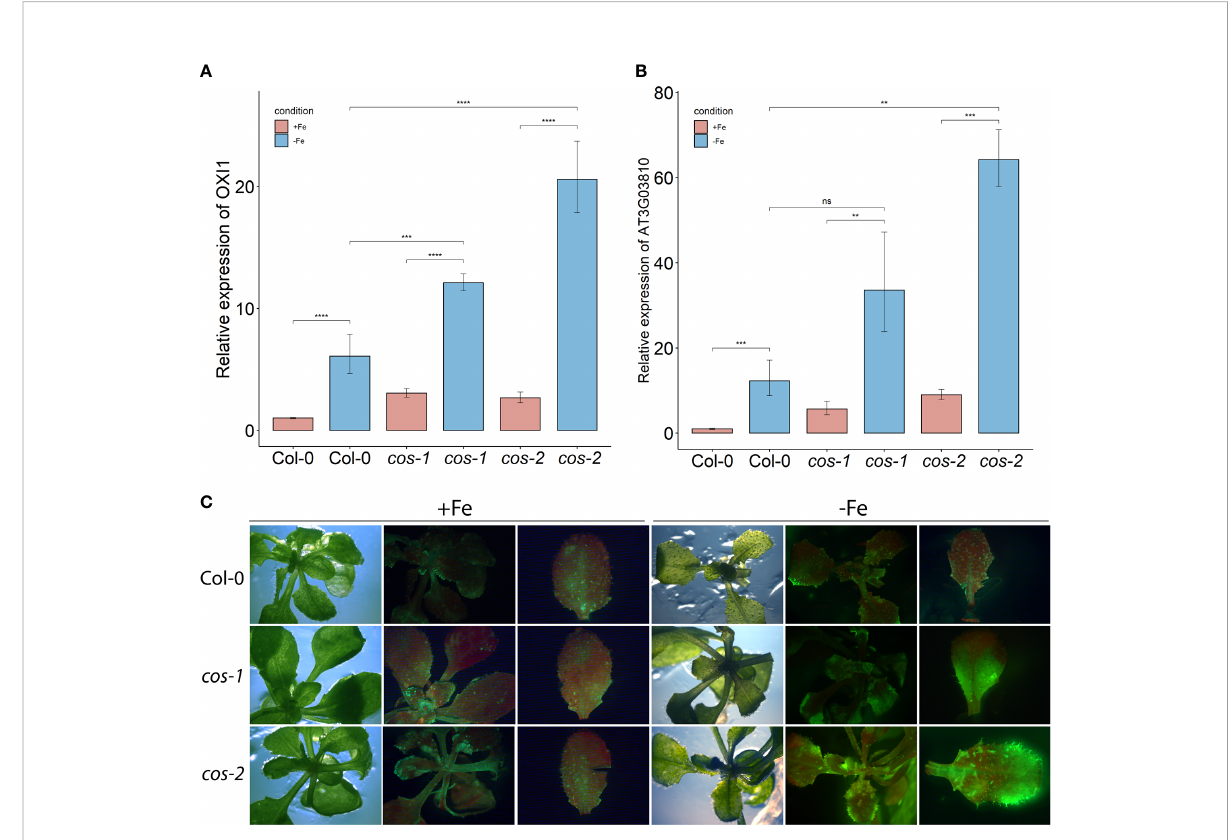
FIGURE 5 ROS in leaves of cos T-DNA mutants. RT-PCR of oxidative stress marker OXI 1 (A) and singlet oxygen marker AT3G0381 0 (B) in WT and cos mutant shoots. Seedlings were grown on 1/2X MS agar with 50 m M Fe-EDTA for 14 d followed by a growth period of 3 d either on Fe-suf fi cient or Fe-de fi cient MS agar medium. Bars represent means ± SD of relative transcript levels normalized to ACT2 (n=3). (C) Singlet oxygen detection in cos mutants by SOSG. Seedlings were grown on 1/2X MS agar with 50 m M Fe-EDTA for 14 d followed by a growth period of 3 d either on Fe- suf fi cient or Fe-de fi cient MS agar medium. Seedlings were stained with SOSG and incubated under high light (500 µmol photons m − 2 s − 1 ) for 30 minutes. SOSG fl uorescence is represented by green while chlorophyll auto fl uorescence is represented by red. * represents p-value ≤ 0.01, ** represents p-value ≤ 0.001, *** represents p-value ≤ 0.0001, **** represents p-value < 0.00001,, ns, not signi fi